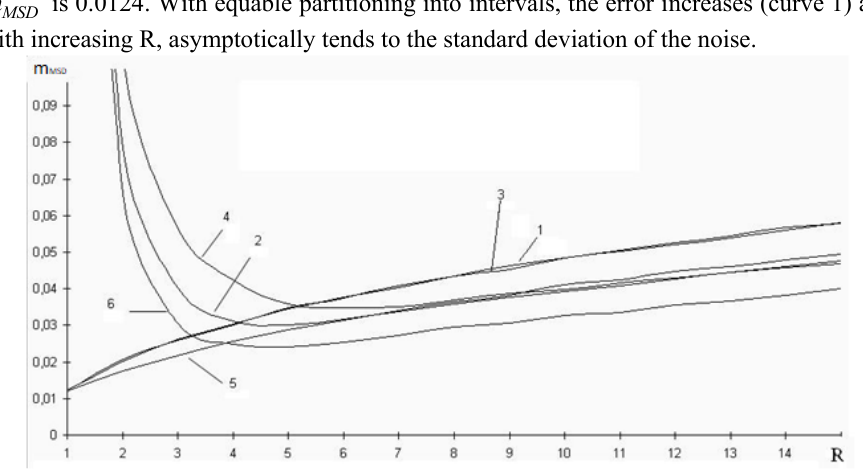
m = f (R) for a priori known and unknown function of useful Fig. 3. Dependence MSD